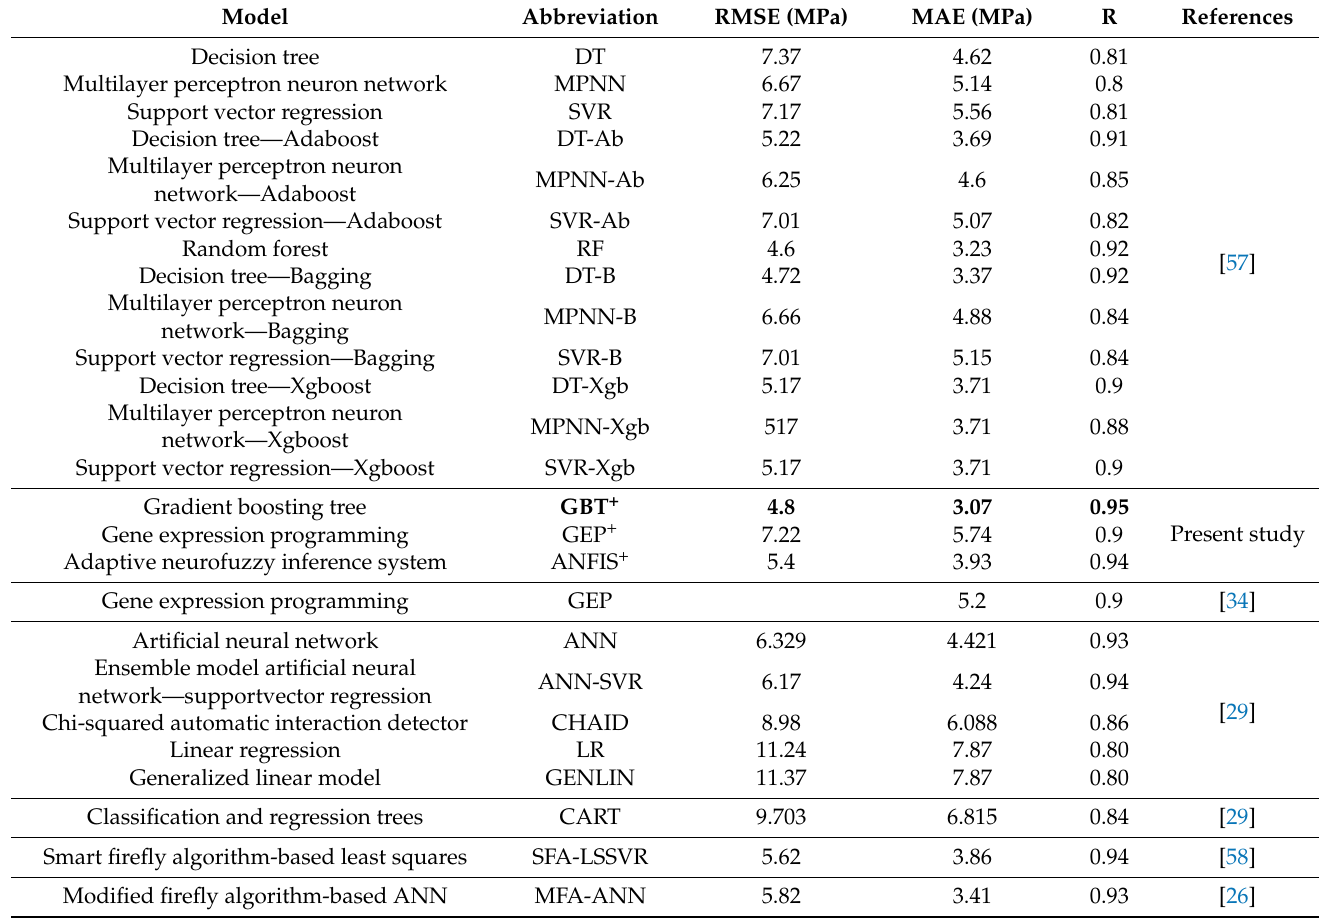
Table 7. Comparison of the performance of the developed models with those previously reported in the